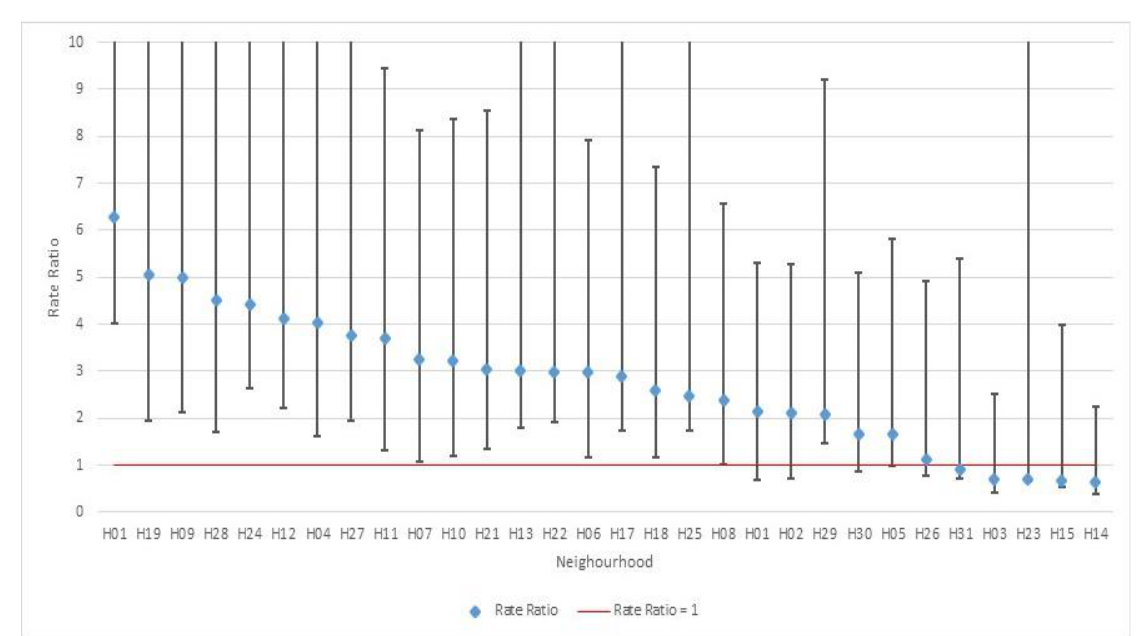
Figure 3. Comparison of the rate of positive healthcare workers to the rate of positivity in the general public per neighborhood. Rate Ratios and confidence intervals for the 30 largest neighborhoods in Jerusalem in descending order.